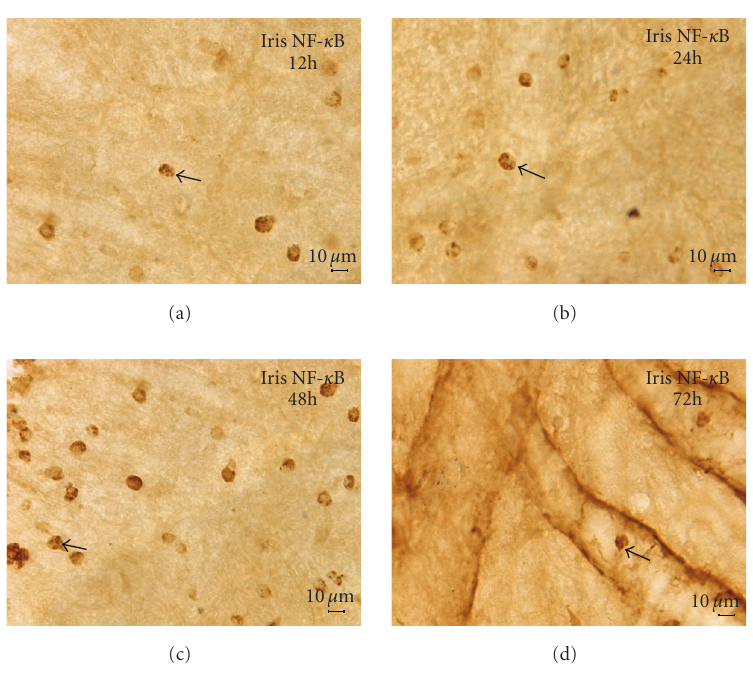
Figure 6: Immunohistochemistry of NF- κ B p65 (DAB): (a) The NF- κ B p65 positive cells were shown at 12h. (b) The NF- κ B p65 positive cells increased at 24 h. (c) NF- κ B p65 located in the cytoplasm or nucleus at 48h. (d) NF- κ B p65 positive cells had been decreased in the iris at 72h (Bar = 10 μ